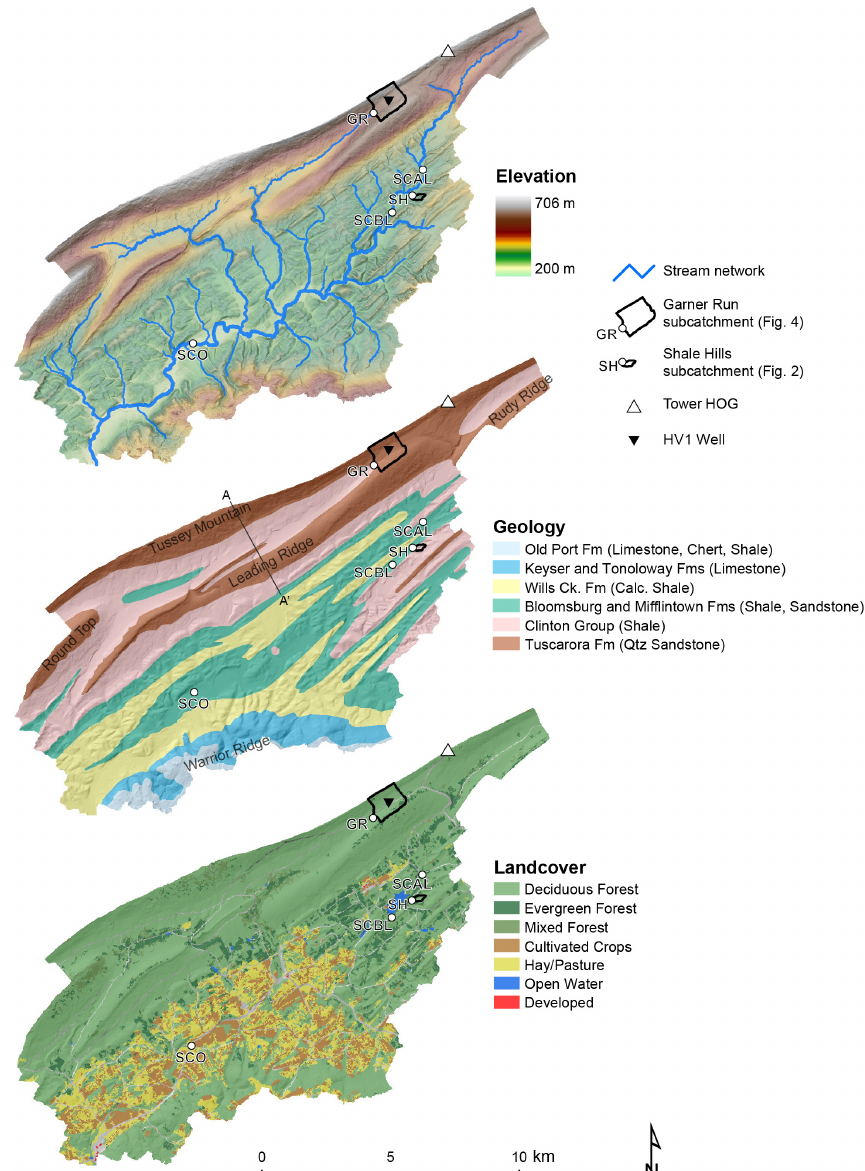
Figure 3. Map of Shavers Creek watershed, highlighting (a) topography derived from airborne lidar, (b) geology (Berg et al., 1980), and (c) land use (Homer et al., 2015). In moving from “measure everything everywhere” (our paradigm in the 8ha Shale Hills catchment; SH) to “measure only what is needed” in the Shavers Creek watershed (164km 2 ), we chose to investigate two new first-order subcatchments: a forested sandstone site (along Garner Run, marked GR) and an agricultural calcareous shale site (to be determined). In addition, three sites on Shavers Creek have been chosen as stream discharge and chemistry monitoring sites (marked SCAL – Shavers Creek above lake; SCBL – Shavers Creek below lake; and SCO – Shavers Creek outlet). Location of Fig. 4 is indicated by cross section